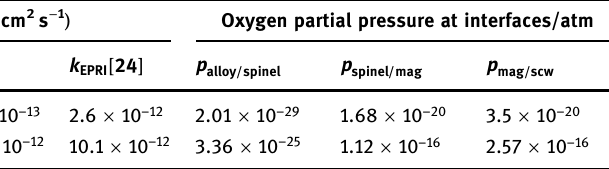
Table 6: The oxidation rate of internal and external oxides, k mag , k spinel , the overall oxidation rate, k oxide , and oxygen partial pressure of interfaces Alloy